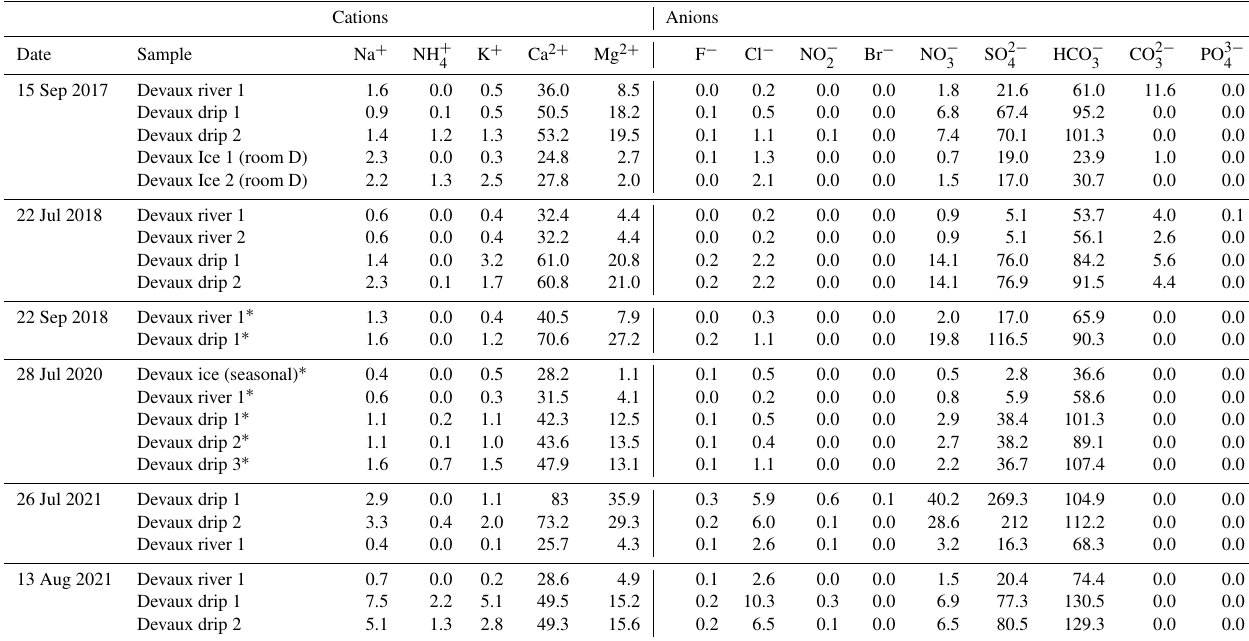
Table 1. Chemical composition of water and ice samples from Devaux cave (in mgL − 1 ). ∗ signifies samples where TDSs (total dissolved solids) were calculated.